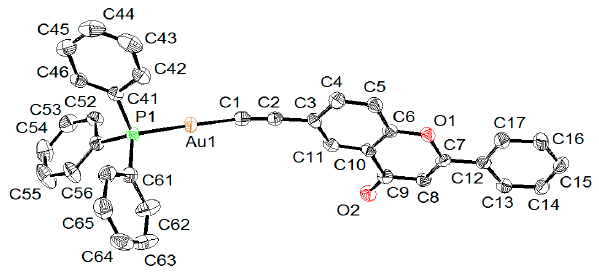
Figure 1. ORTEP drawing of 5 at 50% probability ellipsoids with hydrogen atoms and solvent molecules omitted for clarity.